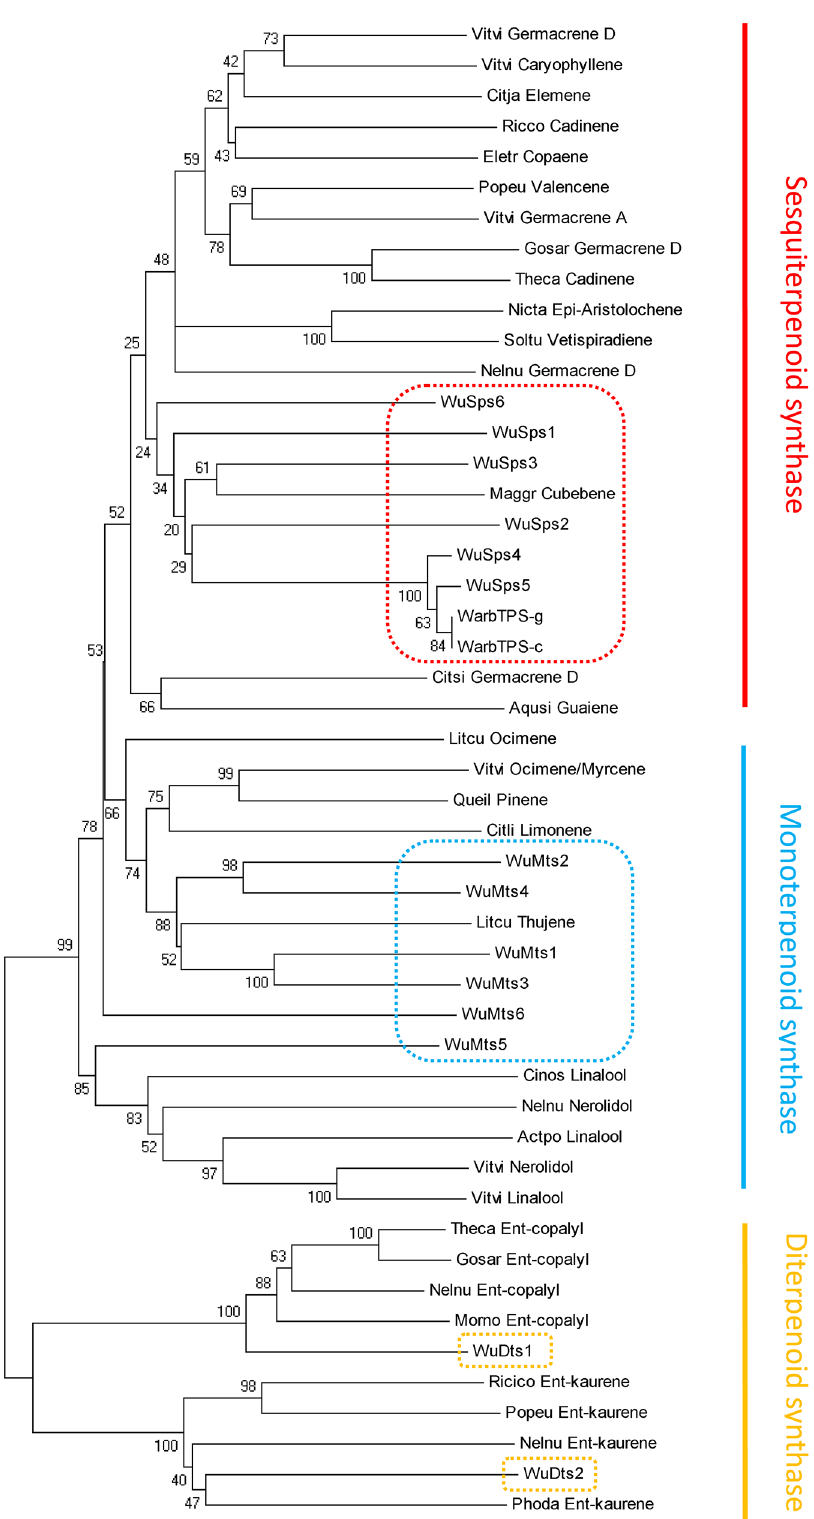
Fig 5. Phylogenetic tree of terpene synthases. Phylogenetic analysis of 14 putative W . ugandensis WuTPS protein sequences with their homologs from other plants indicates that they are clustered into